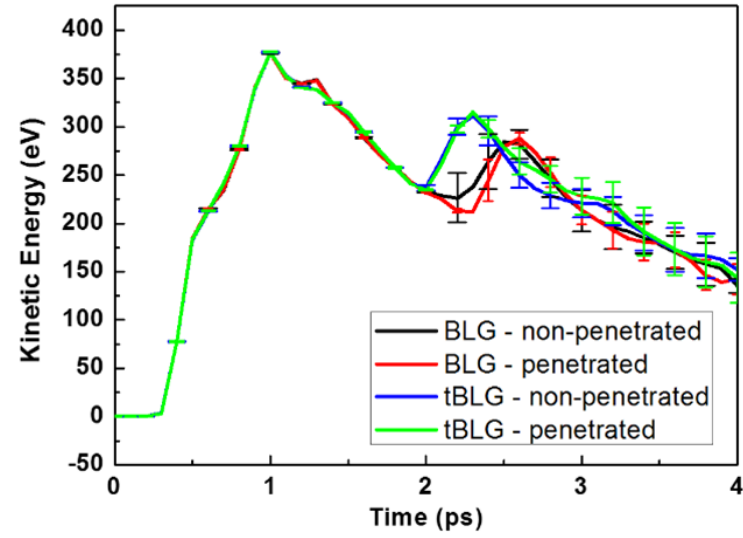
Figure 5. The total kinetic energy of atoms within the impact region in each case evolving with time.